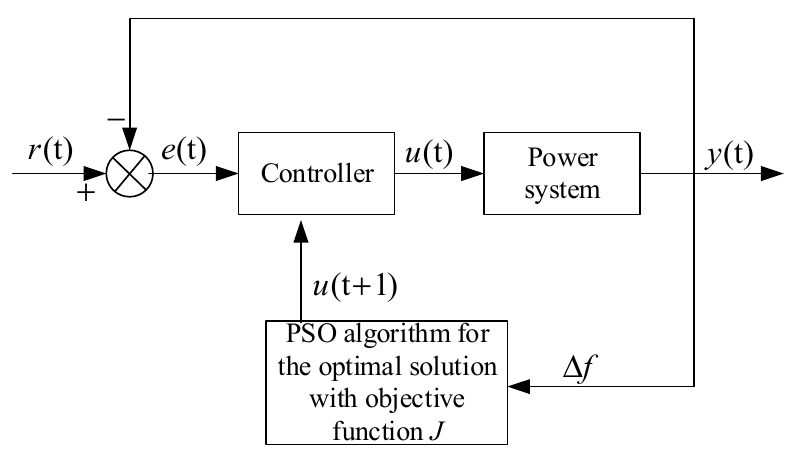
Figure 3. PSO-MPC of the power system.